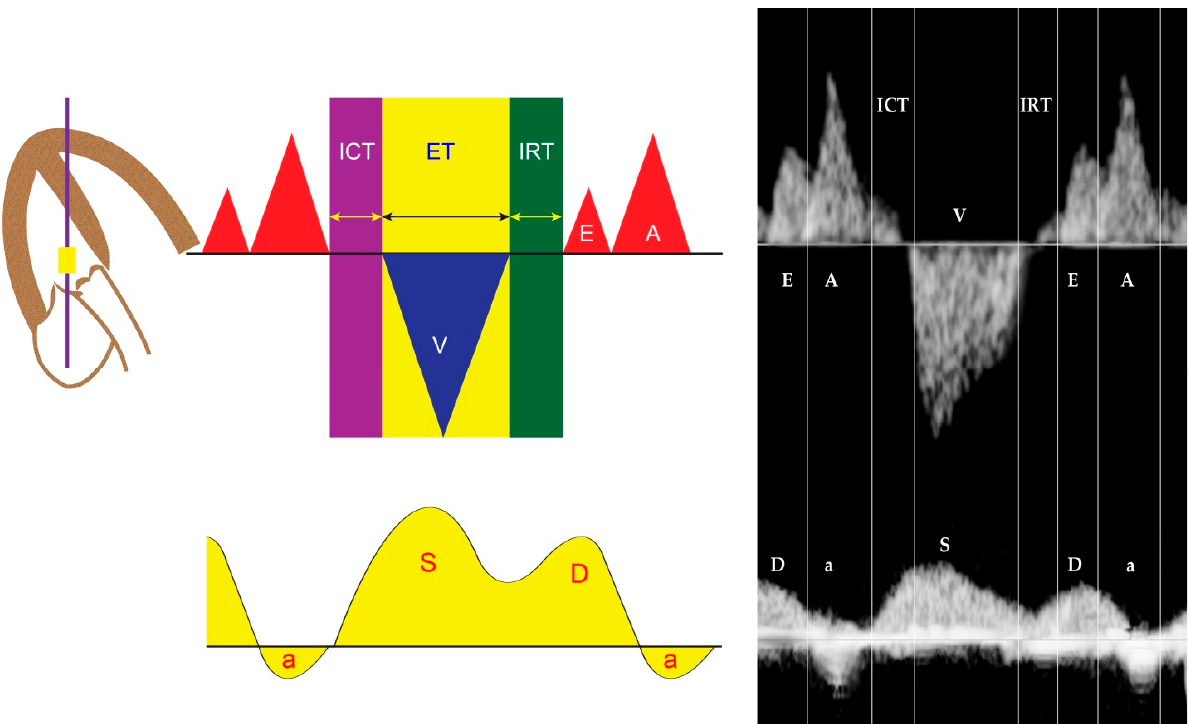
Figure 1. Cardiac cycle and Tei index of the left ventricle (placing the sampling cursor just below the mitral valve and outflow): correlation between Doppler waveforms of intra-cardiac flow and venous flow in the inferior vena cava (a: A-wave; D: D-wave; ET: ejection time; ICT: isovolumetric contraction time; IRT: isovolumetric relaxation time; S: S-wave; V: ventricular